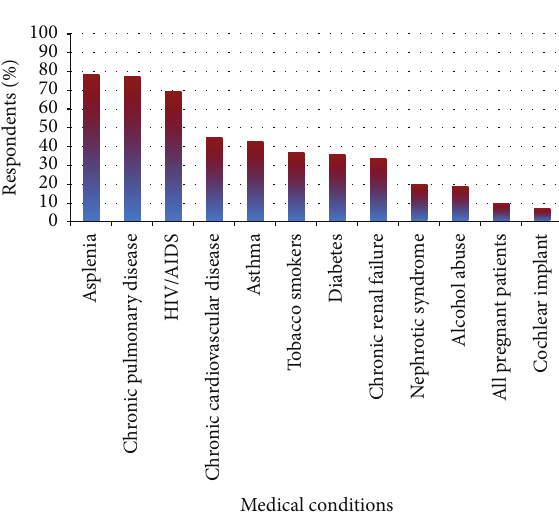
Figure 2: Responses to knowledge questions regarding indications for pneumococcal vaccination in